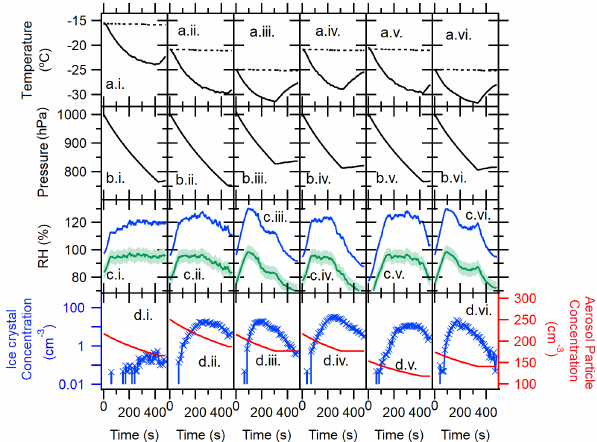
Figure 3. Temporal profiles of the AIDA immersion freezing exper- iment: TXDUST01_07 (i), _08 (ii), _30 (iii), _12 (iv), _13 (v), and _32 (vi). Arrays of alphabetical panels represent the chamber gas temperature (solid line) and the chamber wall temperature (dashed line) (a) , pressure in the AIDA chamber vessel (b) , RH with respect to water (green line) and ice (blue line) (c) , and aerosol particle con- centration measured by the CPC (red solid line) as well as number concentration of > 20µm D ve AIDA particles measured by a welas optical particle counter (blue line) (d) . Horizontal numerical panels represent different sample types and AIDA experiments, including TXD01 (i)–(iii) and TXD05 (iv)–(vi). RHs were determined with an accuracy of ± 5%, represented as the green shaded area in (c) , using the mean gas temperature and the mean water vapor